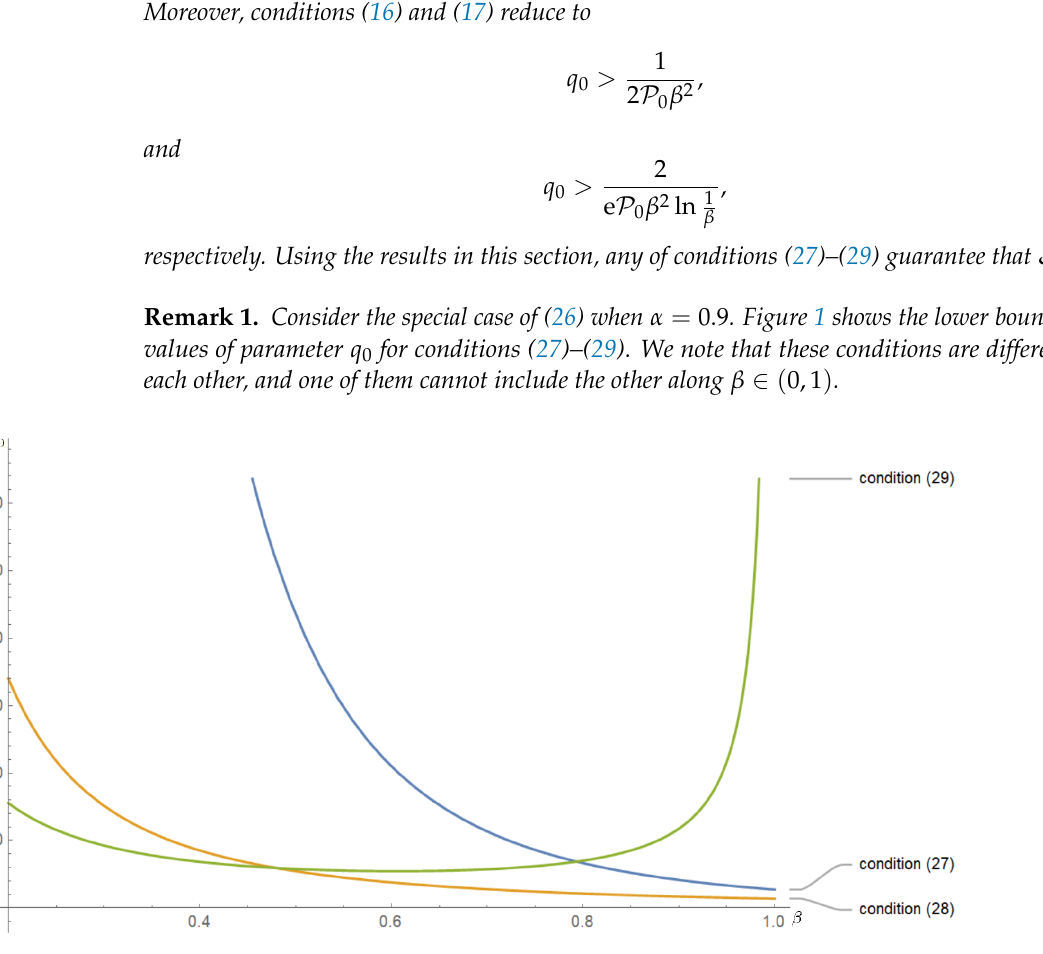
Figure 1. The minimum values of q 0 for which conditions (27)–(29) are